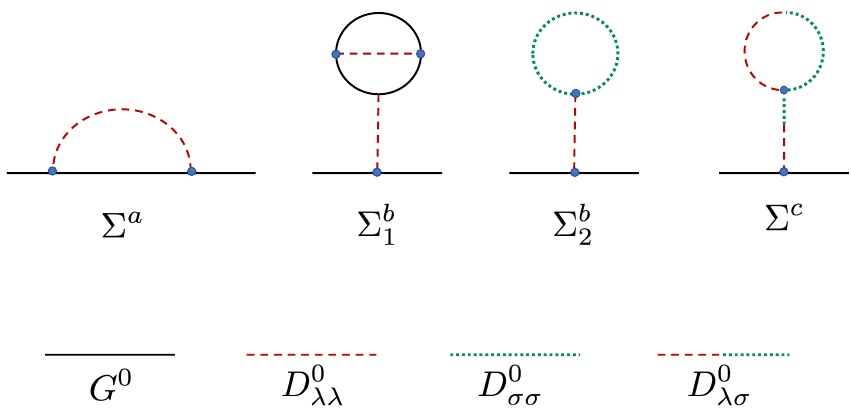
Figure 11: Normal fixed point of the O ( N ) model. Diagrams contributing to the self- energy Σ ( x , x (cid:48) ) , Eq. (89), at O ( 1 / N ) . Notation for propagators is introduced in the bottom of the figure; blue dots mark interaction